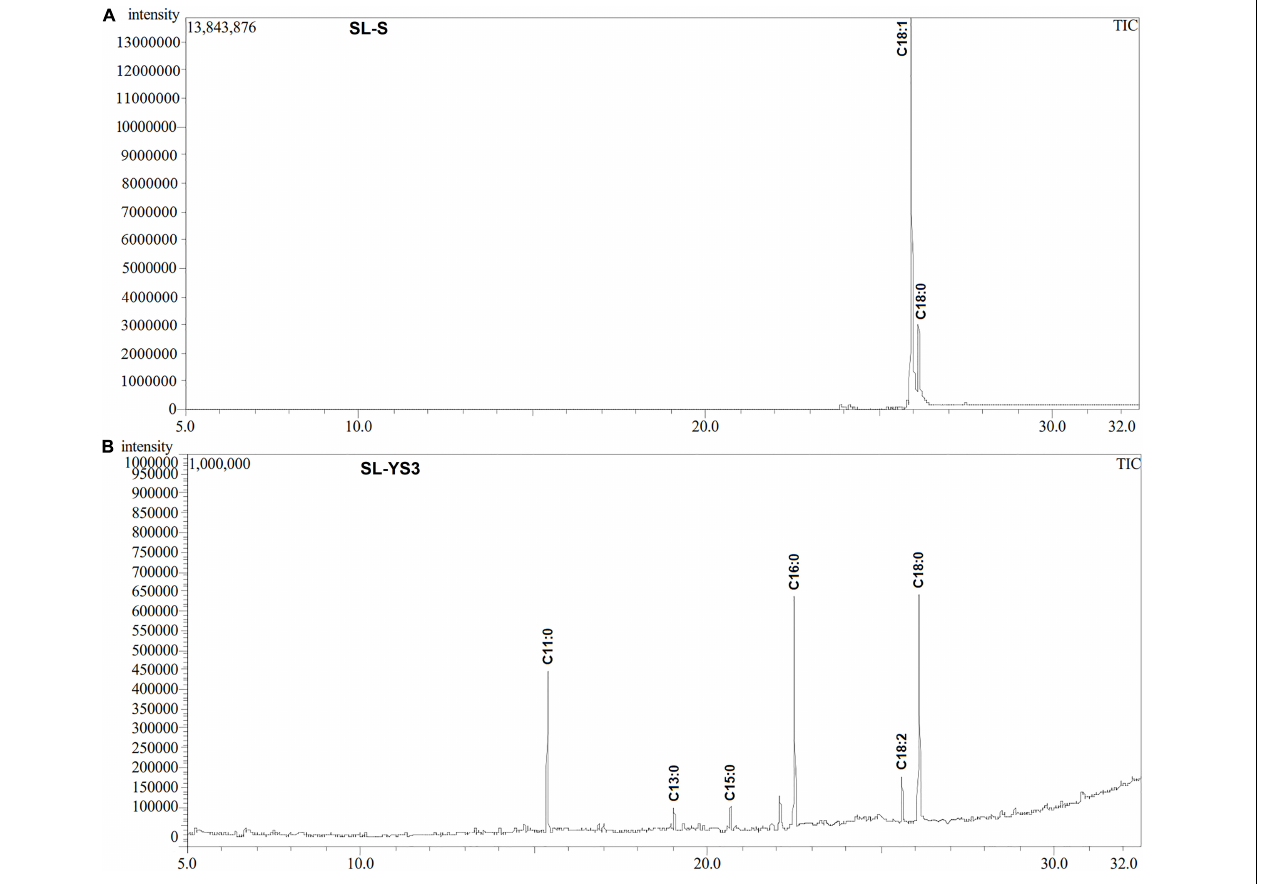
FIGURE 1 | Gas chromatography profiles (TIC) of the fatty acid methyl esters (FAMEs) of the (A) standard sophorolipid (SL-S) and (B) the sophorolipid produced by Rhodotorula babjevae YS3 (SL-YS3).